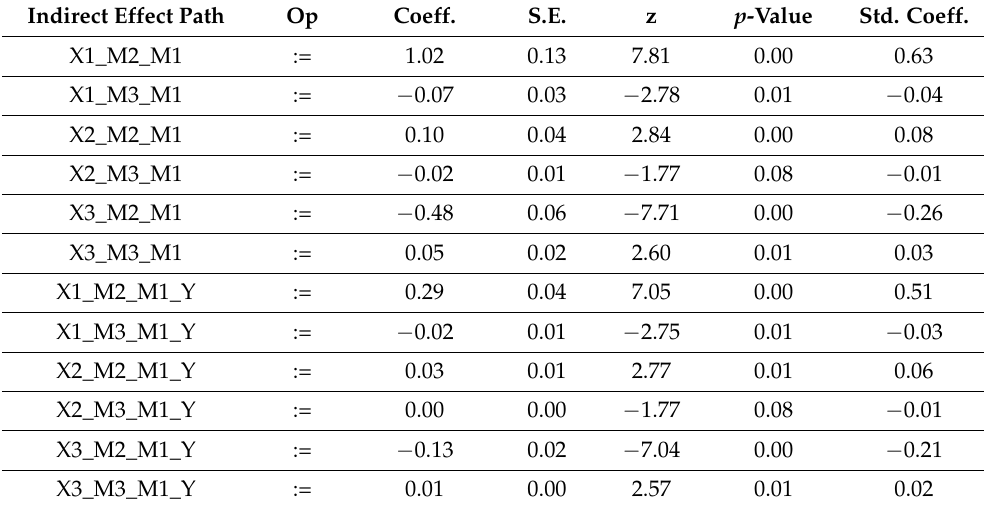
Table 3. Indirect